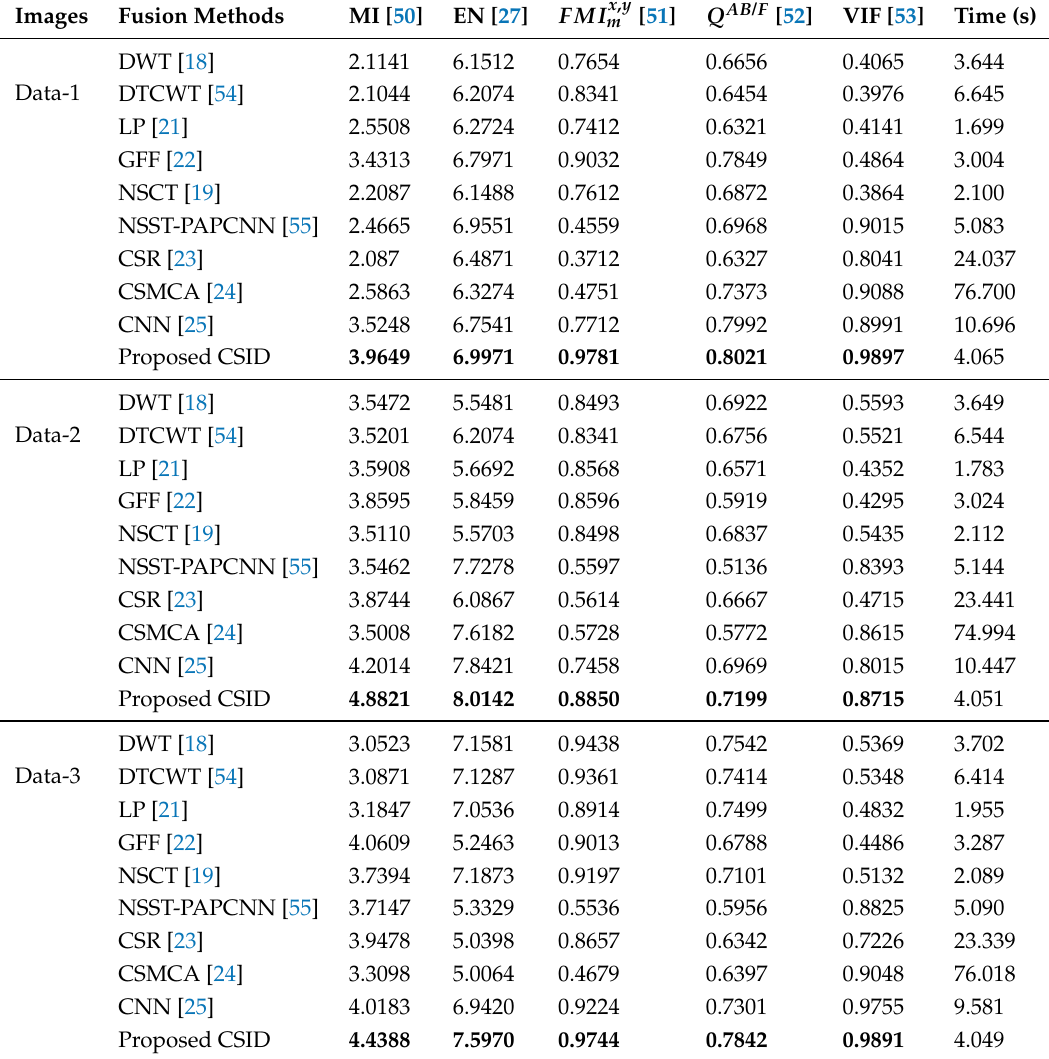
Table 1. The quantitative comparison of fusion methods. Best values are shown in bold. Images Fusion